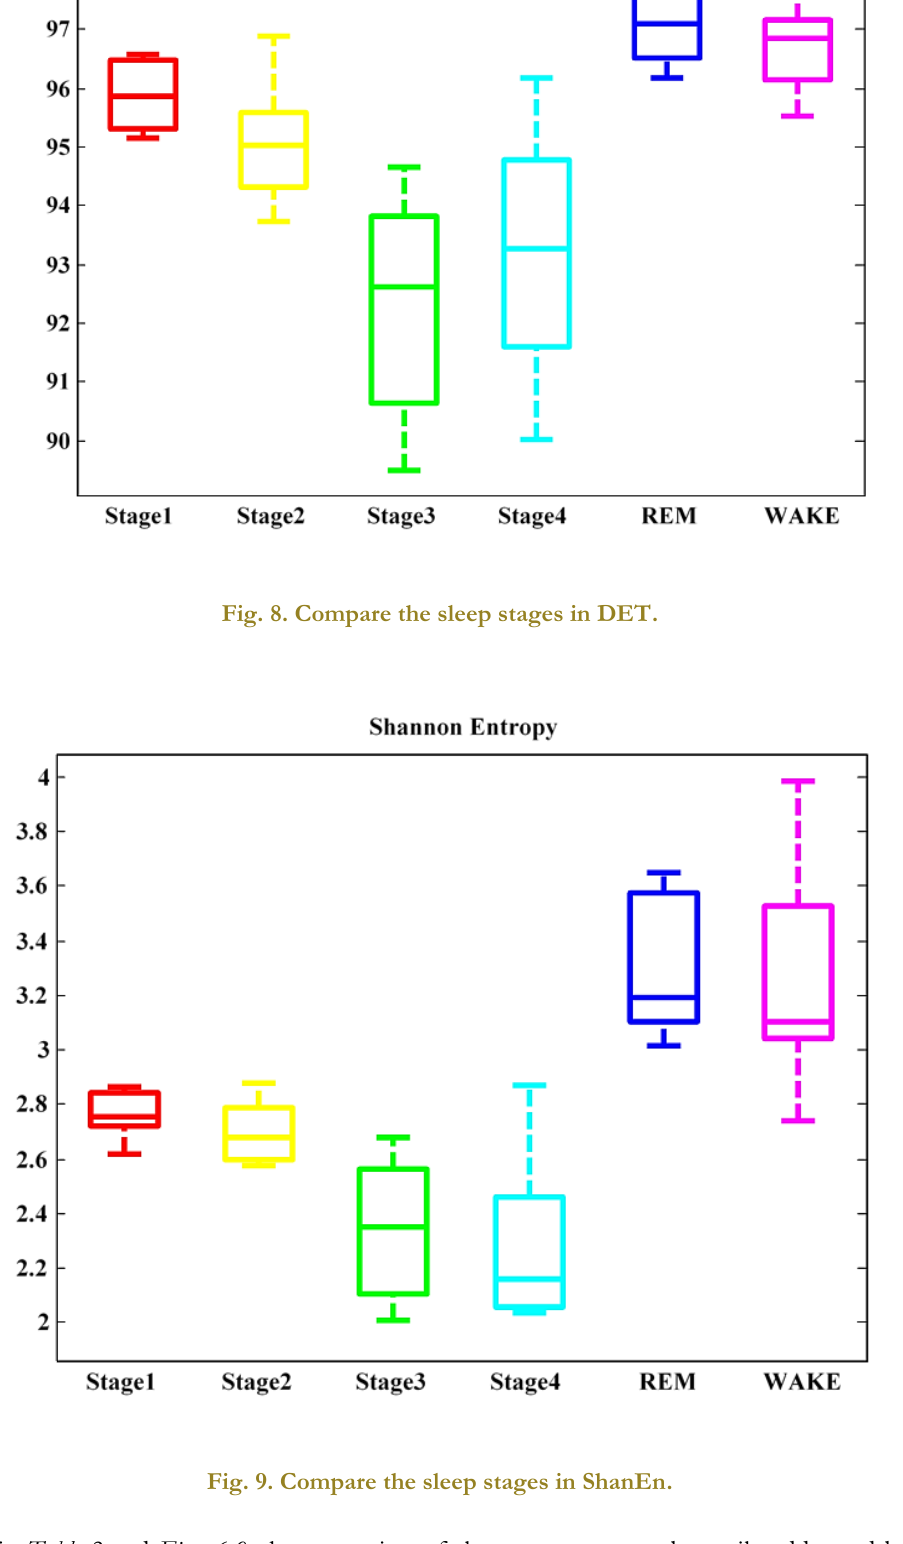
Fig. 9. Compare the sleep stages in